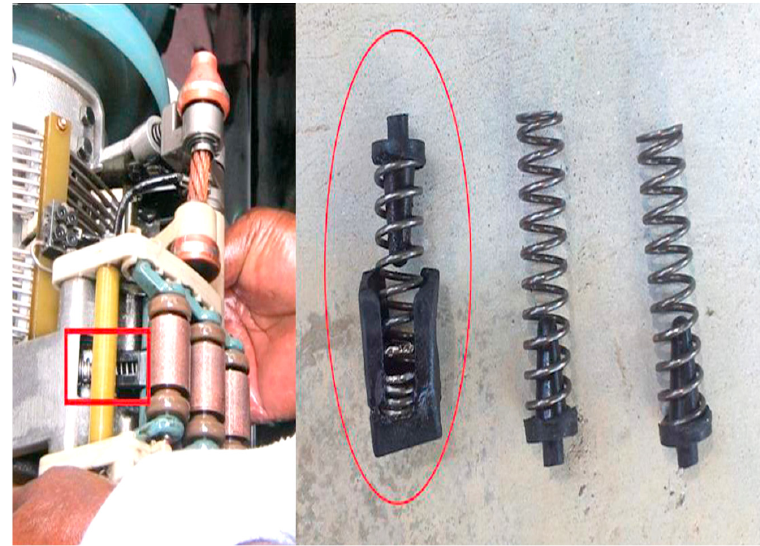
Figure 4 . Broken contact springs [13]. Figure 4. Broken contact springs [13].